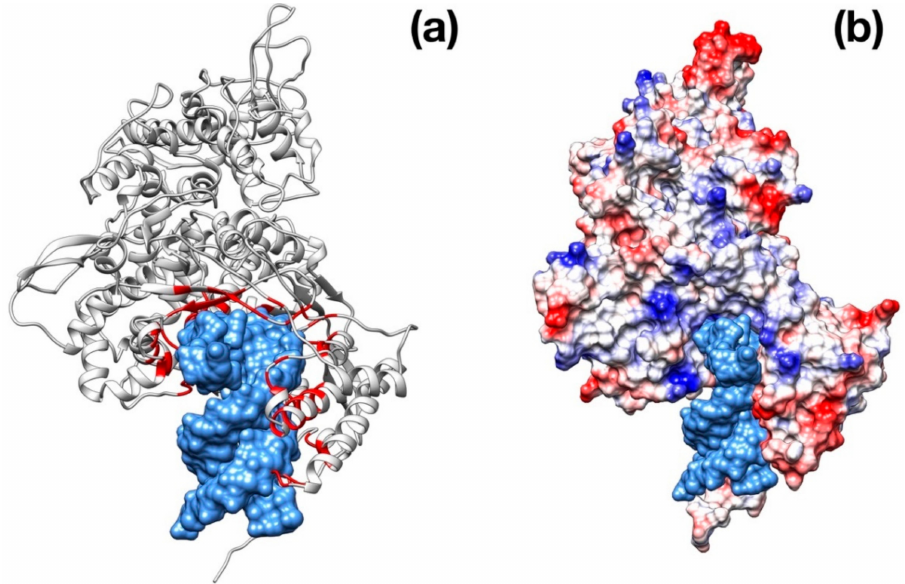
Figure 6. Structural representation of the RdRp monomer from SARS–CoV-2. ( a ) Superposition with the structure poliovirus RdRp in complex with RNA primer (PDB id: 3OL6, only the nucleotide fragment is shown for clarity). The residues in contact with RNA primer are colored in red. ( b ) Same as in panel ( a ) but with SARS–CoV-2 RdRp molecular surface colored according to the electrostatic